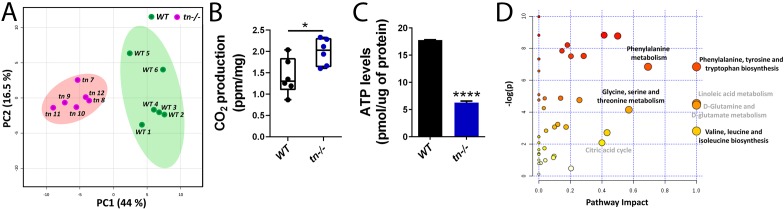
Metabolite analysis upon loss of TRIM32.(A) PCA analysis depicting metabolite variances between WT (green) and tn-/- (magenta) L3 larvae. PC1, principal component 1. PC2, principal component 2. (B) Scatter plot reveals CO2 production is slightly elevated upon loss of TRIM32 in all tissues. N = 5. (C) Bar graph depicts reduction in ATP levels in tn-/-L3 larvae. N = 25. (D) Pathway analysis reveals a large proportion of amino acid biosynthetic pathways are impacted upon loss of TRIM32. p-Value significance is plotted on the y-axis (yellow to red depict increased p-values). More metabolites affected in a particular pathway increase from left to right along the x-axis. Mean +/- SD (****, p<0.001; *, p<0.05).